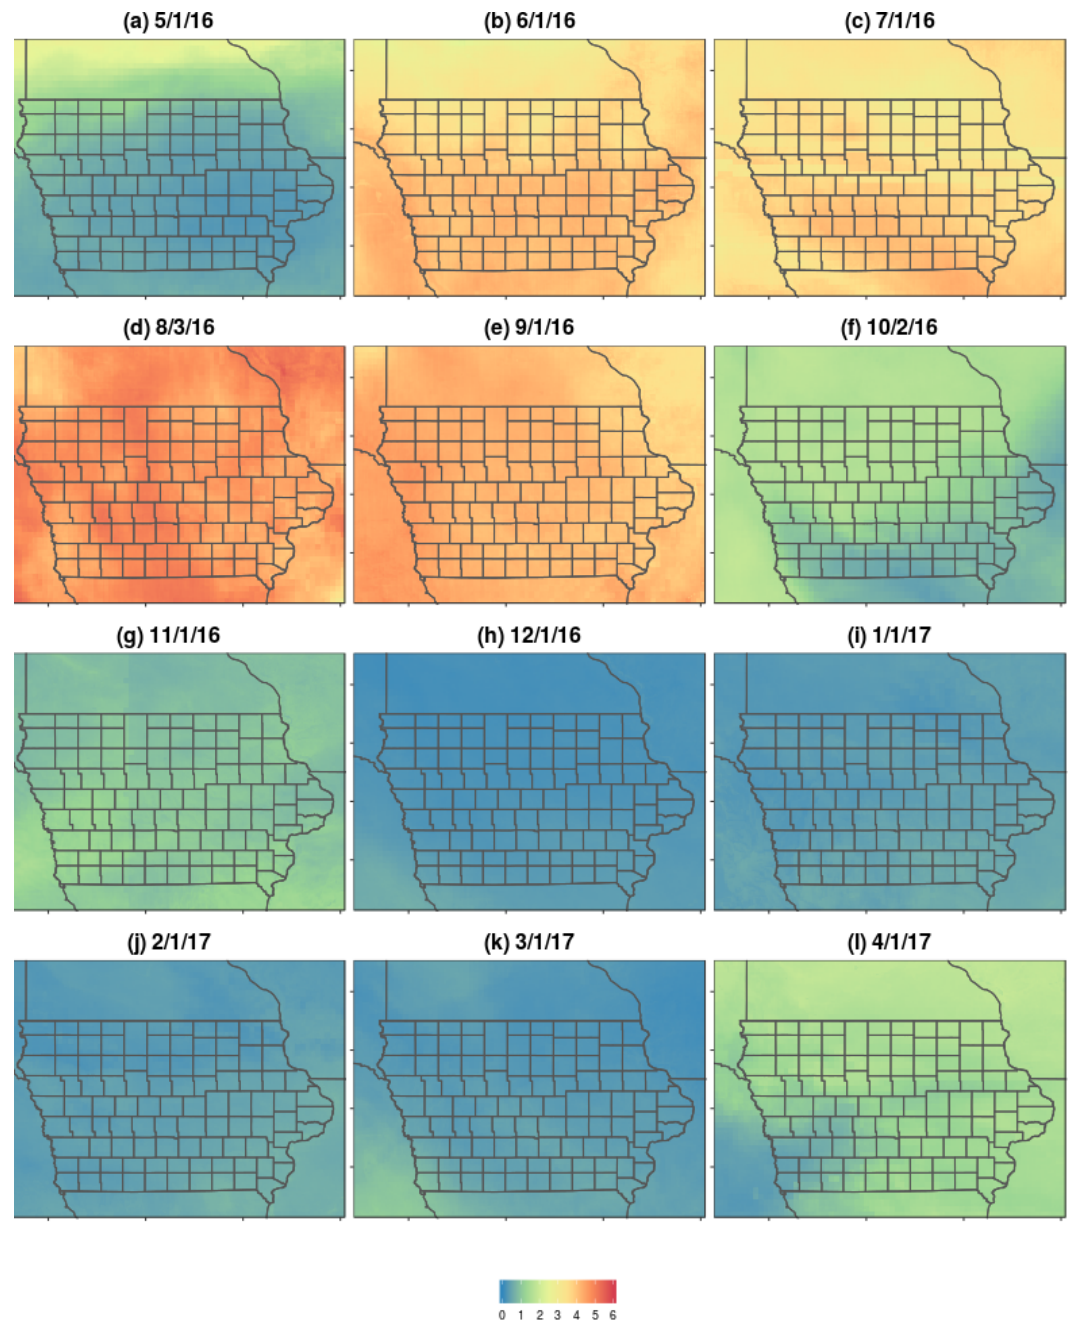
Figure 9. Estimated daily AET maps (mm d − 1 ) using the High-Resolution Rapid Refresh-Geostationary Operational Environmental Satellite (HRRR-GOES) dataset over the state of Iowa during the study period.